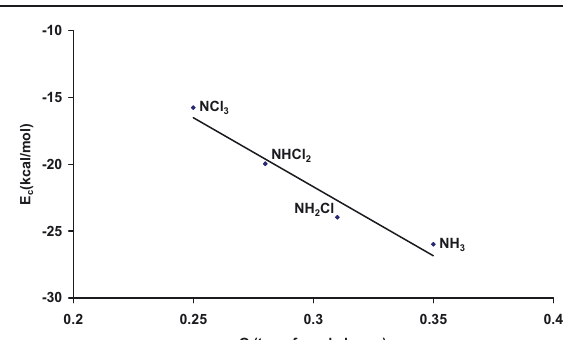
Figure 2. Linear correlation between MP2-NBO transferred charge Cl Lewis bases and G2(MP2) cal- n 3-n BNH Cl (n= 0-3) 3 n 3-n